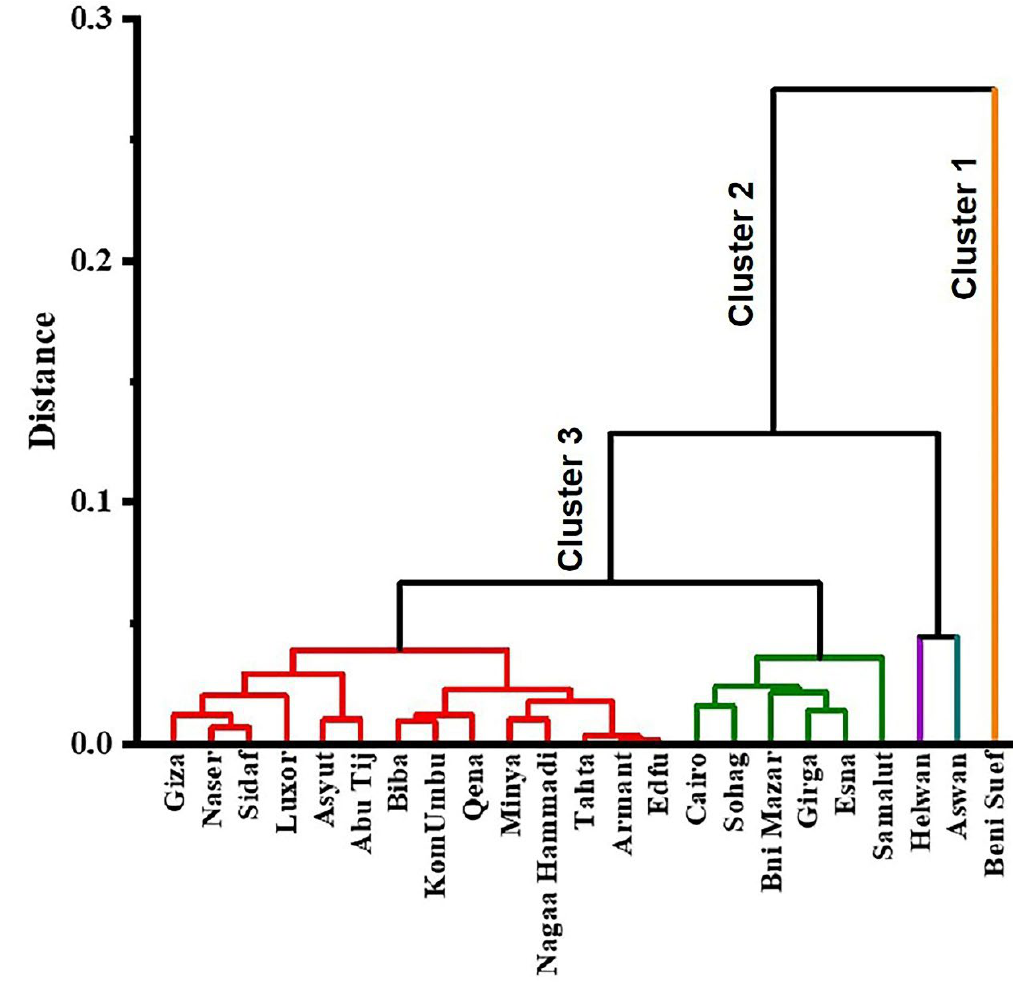
Figure 8. Dendrogram: a cluster of variables based on similarity.